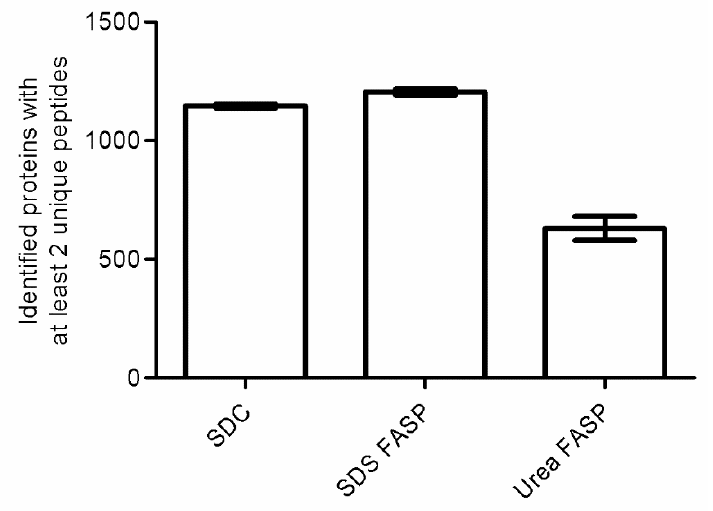
Figure 1. Bar plot comparing the number of identified proteins using different protocols for protein extraction and tryptic digestion from truffle powder of T. indicum . Proteins had to be identified with at least two unique peptides. Error bars indicate standard deviation of technical triplicates.